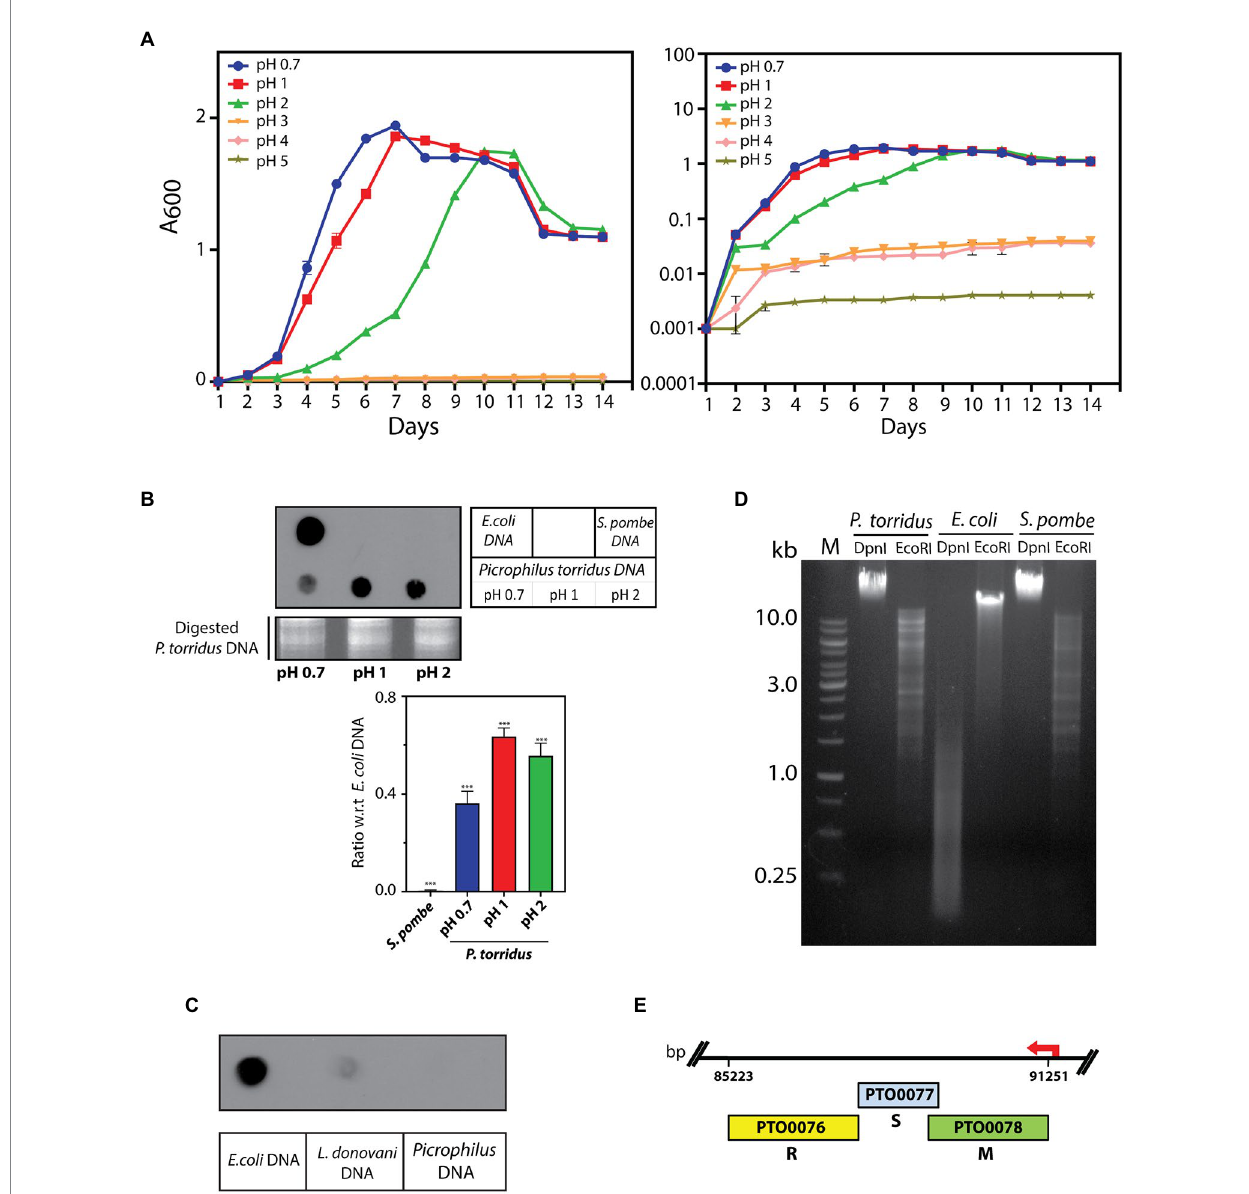
FIGURE 1 (A) Analysis of growth of P. torridus at different pH. Cultures were initiated with 1% (v/v) inoculum from a starter culture at pH 1.0 that was at OD 600 ~ 1.5. Growth was monitored every 24 h. Graph represents average values of three experiments and error bars represent standard deviation. Left panel: data plotted against linear y-axis. Right panel: data plotted against log y-axis. (B) Dot blot analysis of P. torridus genomic DNA for m6A mark. 1 μ g of genomic DNA was used in each case. Upper left panel: blot probed with anti-m6A antibody (1:1000 dil). Loading control: agarose gel analysis of input genomic DNA digested with EcoRI. Upper right panel: loading scheme of dot blot. Lower panel: quantification of P. torridus genomic DNA signal as a ratio of E.coli genomic DNA signal, done using ImageJ software. Bars represent average of three experiments. Error bars represent standard